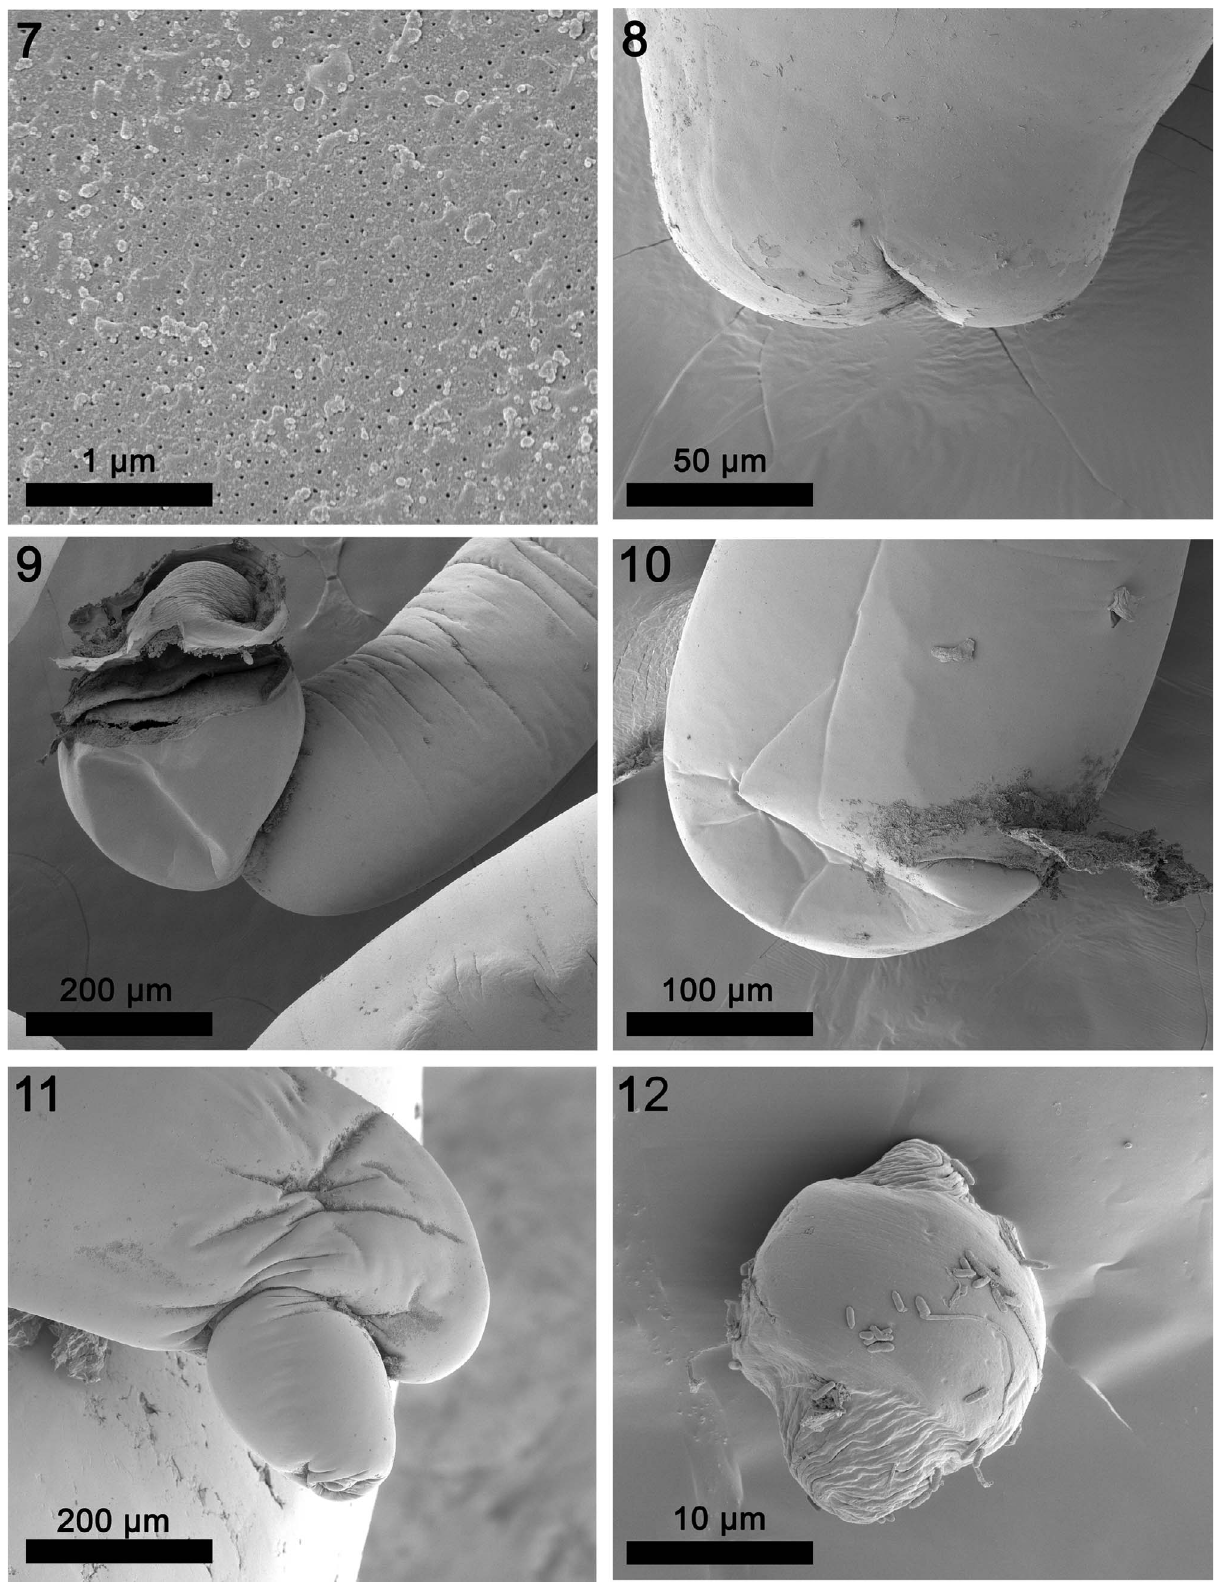
Figures 7 – 12. SEM of specimens of Neoechinorhynchus johnii from Eleutheronema tetradactylus, Johnius carouna, and Otolithes ruber in the Paci fi c Ocean off Vietnam. (7) Micropores at the posterior trunk of the same male specimen in Figure 6. Note the different pore diameter and distribution indicative of differential nutrient absorption of different parts of the trunk. (8) The posterior end of a male specimen showing the site of the invaginated bursa. (9) The plain evaginated bursa tilting ventral at the posterior end of a male specimen. (10) Normal rounded outline of the posterior end of a female specimen. (11) A constriction occasionally seen at the posterior end of female specimens contains the looped posterior end of the reproductive system. (12) An egg of the lantern-like variety with fi brous